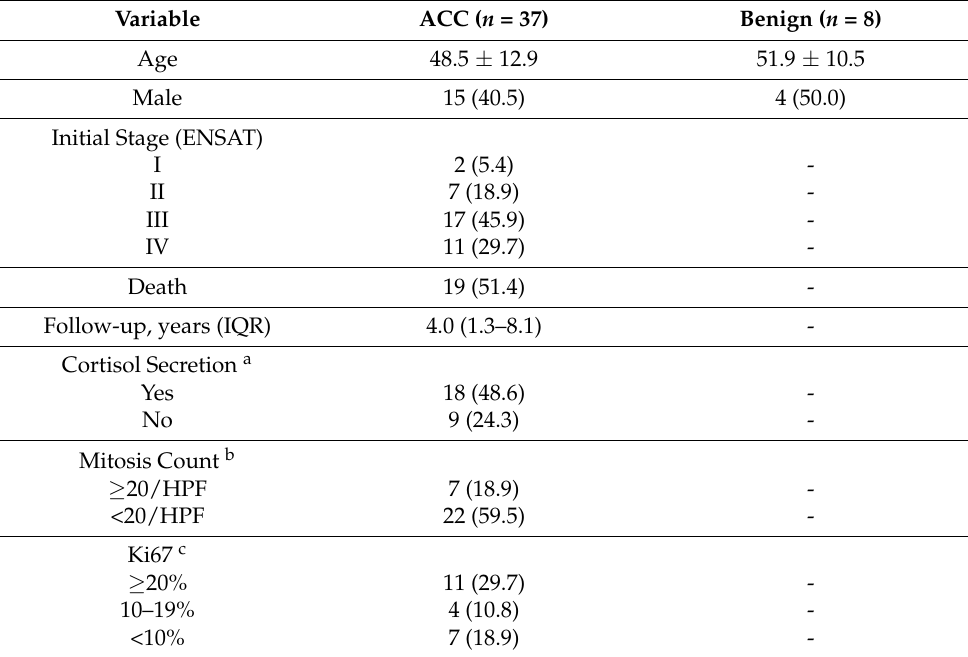
Table 1. Baseline characteristics of patients with adrenal cortical carcinoma ( n = 37) and benign adrenal adenoma ( n =